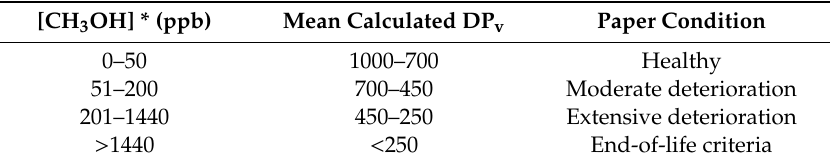
Table 6. Methanol threshold level and its condition [87].